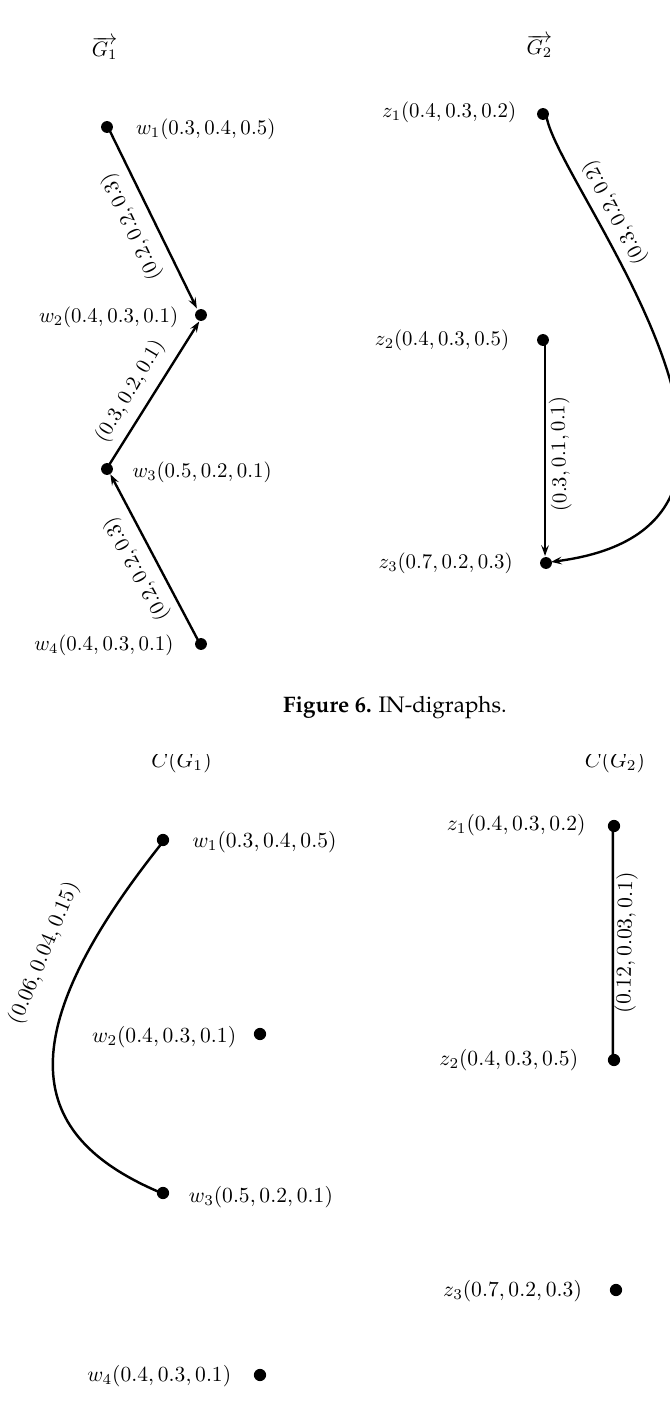
Figure 6. IN-digraphs.